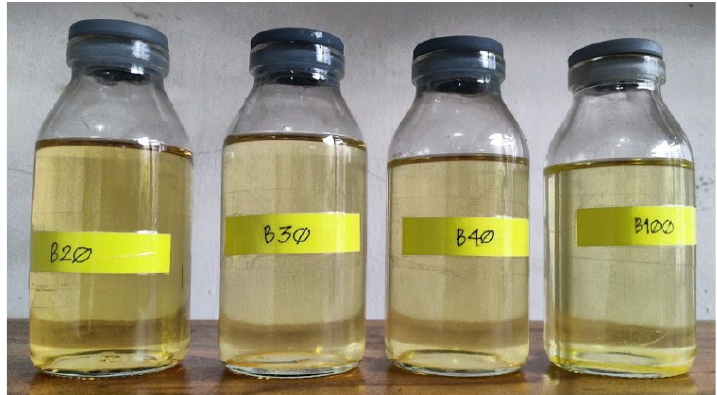
Figure 2. Pure PEME and its blend variations.